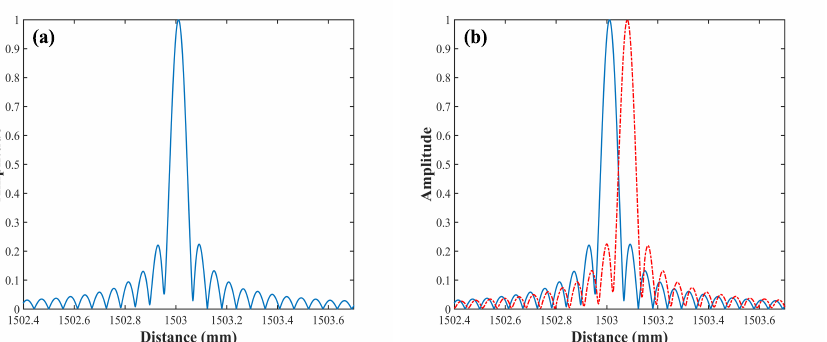
Figure 7. The results of the distance measurements, ( a ) single point ranging resolution, ( b ) single point 70 µ m displacement ranging